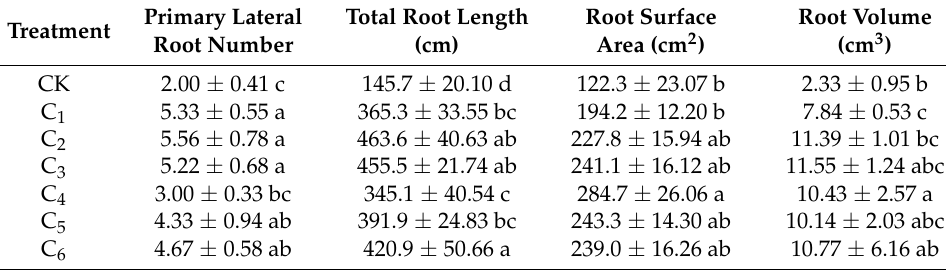
Table 4. The root morphological indexes of S. sebiferum container seedlings in different biochar treatments.